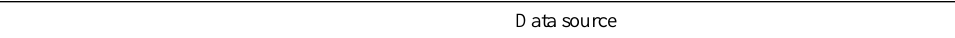
Table 1. The measurement plan.